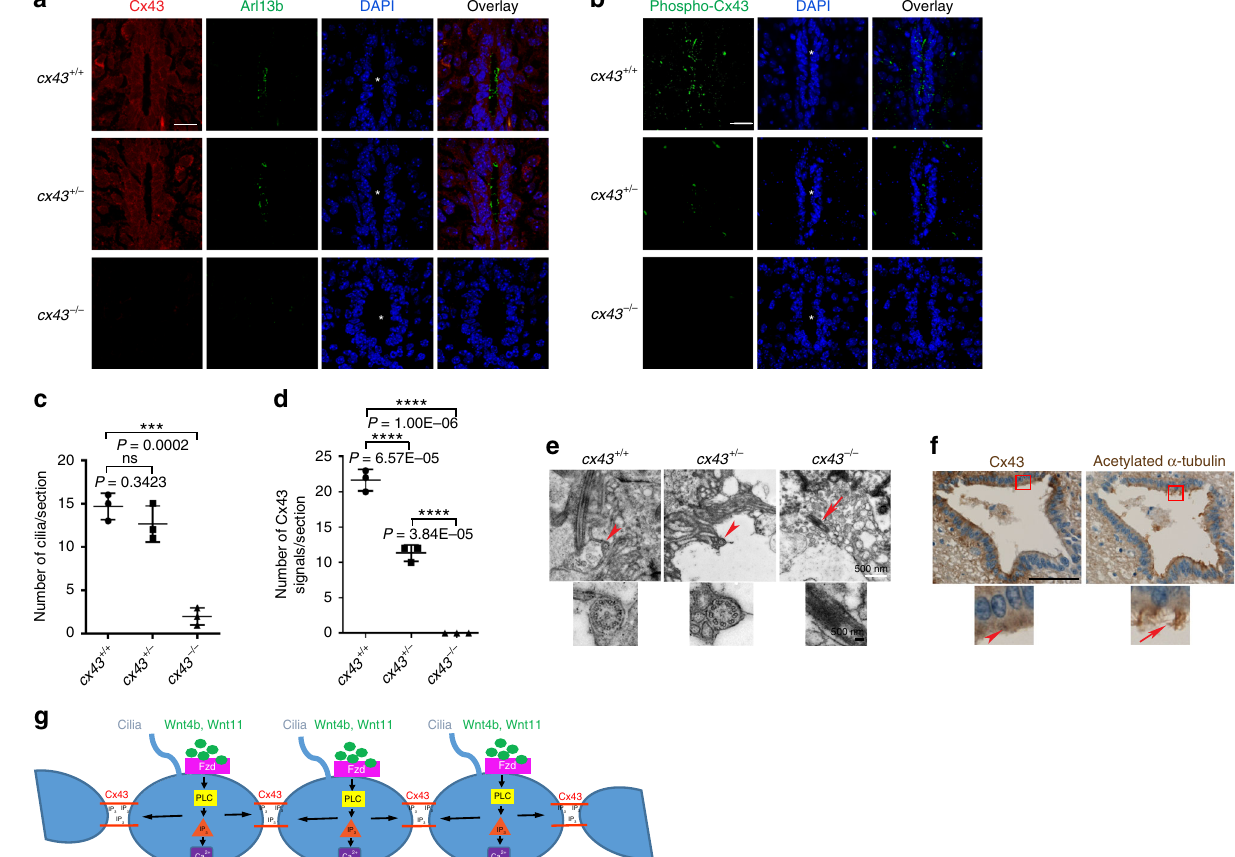
Fig. 6 Cx43 null mice have reduced motile cilia in ECs. a , b The SCs of P1 pups with the indicated Cx43 genotype were cross-sectioned, double immunostained with anti-Cx43 and anti-ARL13B antibodies ( a ) or anti-Phospho-Cx43 (Ser386) antibody ( b ), and counterstained with DAPI. Asterisks indicate the central canal (CC). Images are oriented ventral to the bottom. Scale bars = 20 μ m. c , d Quanti fi cations of motile cilia per section in embryos in a and Cx43 signals per section in embyos in b . Mean ± SD. *** P < 0.001 and **** P < 0.0001 by one-way ANOVA with Tukey ’ s HSD post hoc test ( n = 3 mice per group; one frame per mouse). ns, not signi fi cant. e TEM of the SCs of P1 pups with the indicated Cx43 genotype. Arrowheads indicate cross- sectioned motile cilia protruding to the CC and arrow marks a cilium-like structure embedded in an EC. Regions marked by arrowheads or arrow are magni fi ed in the respective lower panels. f The human spinal cord at C1 level from a cadaver was stained with anti-Cx43 and anti-acetylated- α -tubulin antibodies. The boxed areas are magni fi ed in the respective lower panels. Arrowhead denotes staining of Cx43 and arrow motile cilia. Scale bar = 100 μ m. g A proposed model for the maintenance of ependymal motile cilia by the Wnt-PLC-IP 3 -Connexin-Ca 2 +